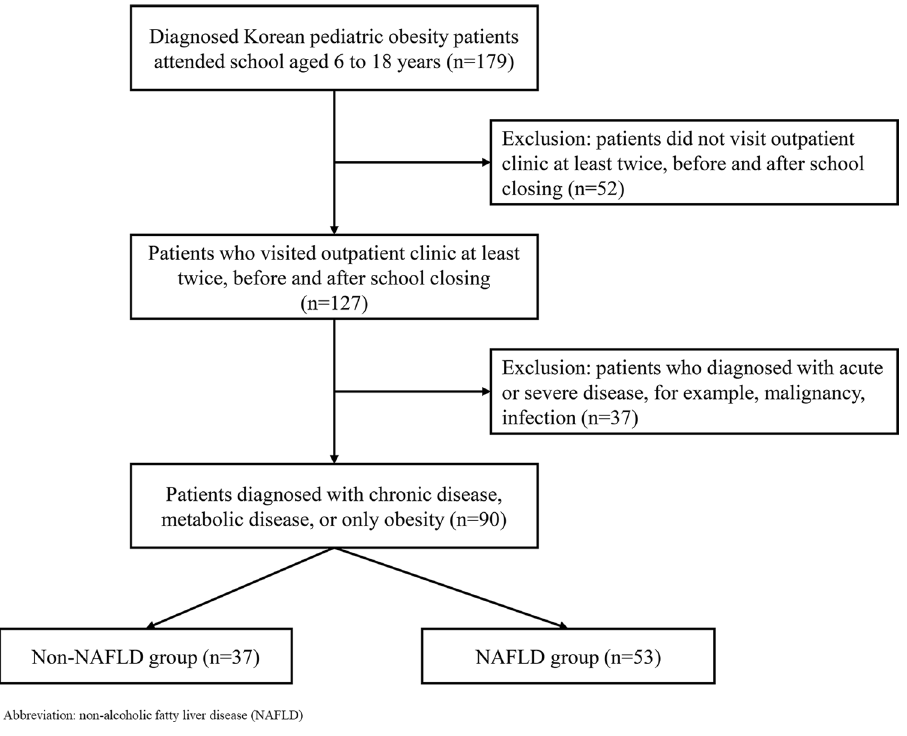
Figure 1. Flow diagram of the